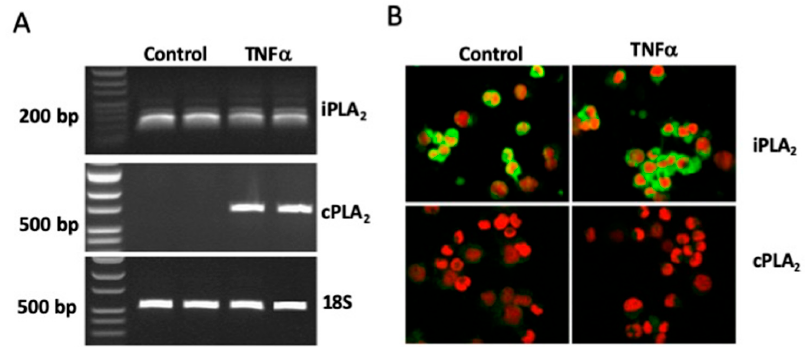
Figure 1. Expression of iPLA 2 β and cPLA 2 α in HMC-1. Cells were stimulated with TNF α (25